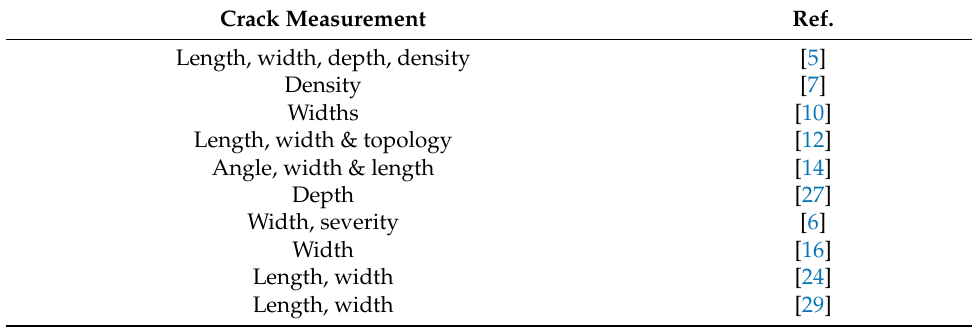
Table 4. Studies focusing on Crack Measurement.